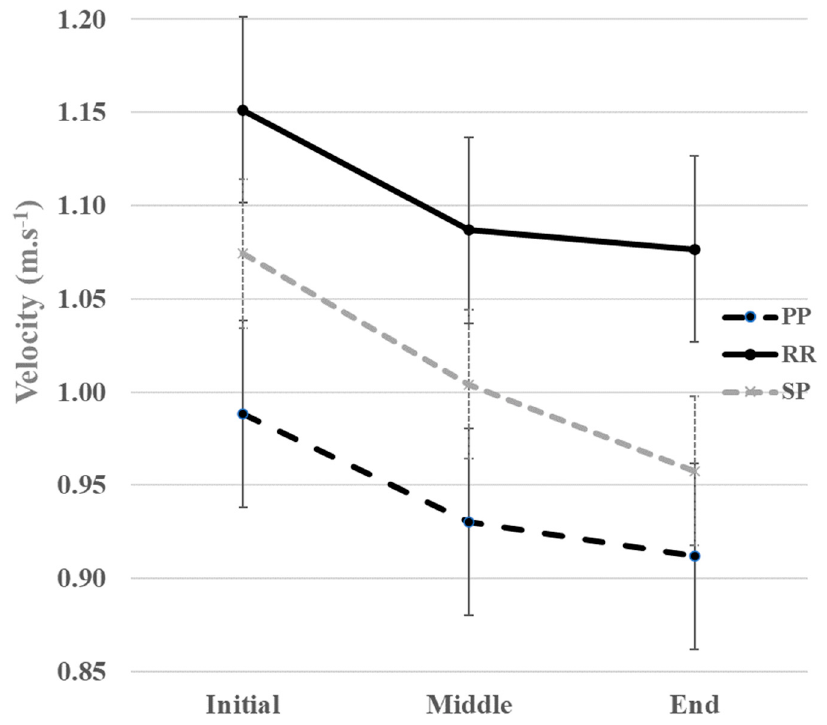
Figure 5. Variations of the velocity during the 6MWT for PwMS with PP, RR, and SP phenotypes. PP, Primary Progressive; RR, Relapsing–remitting; SP, Secondary Progressive. Table 5. Spatio-temporal variables during each interval of the 6MWT for PwMS with PP, RR, and SP phenotypes.